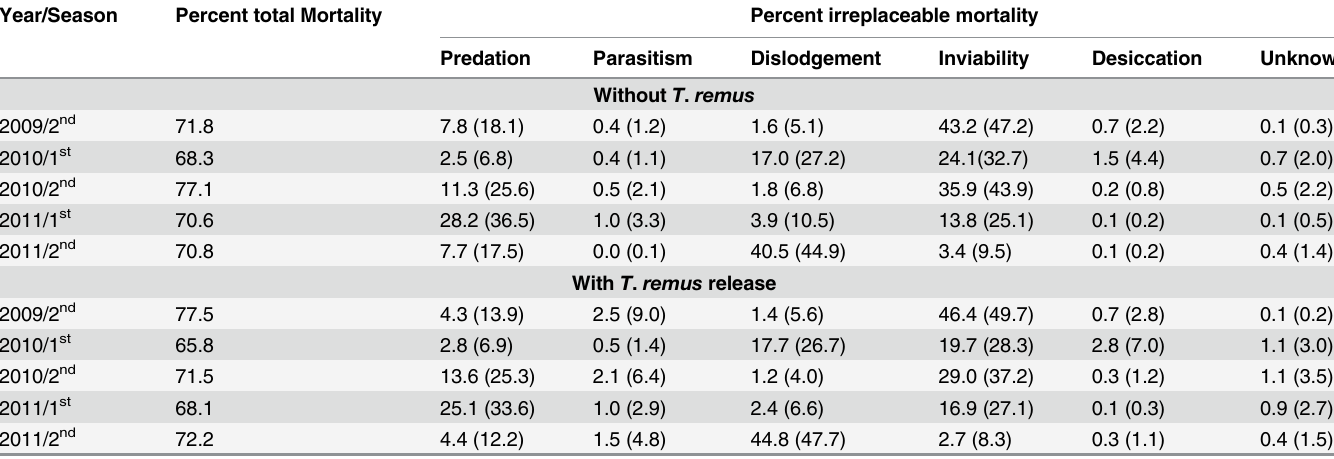
Table 3. Total percentage mortality and irreplaceable mortality by year and seasons for FAW eggs in maize fields with and without Telenomus remus releases.